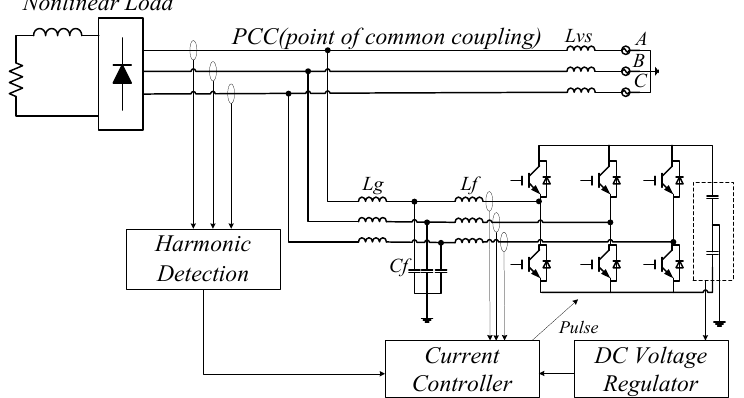
Figure 1. Structure and control scheme of a three-phase four-wire shunt active power filter system.